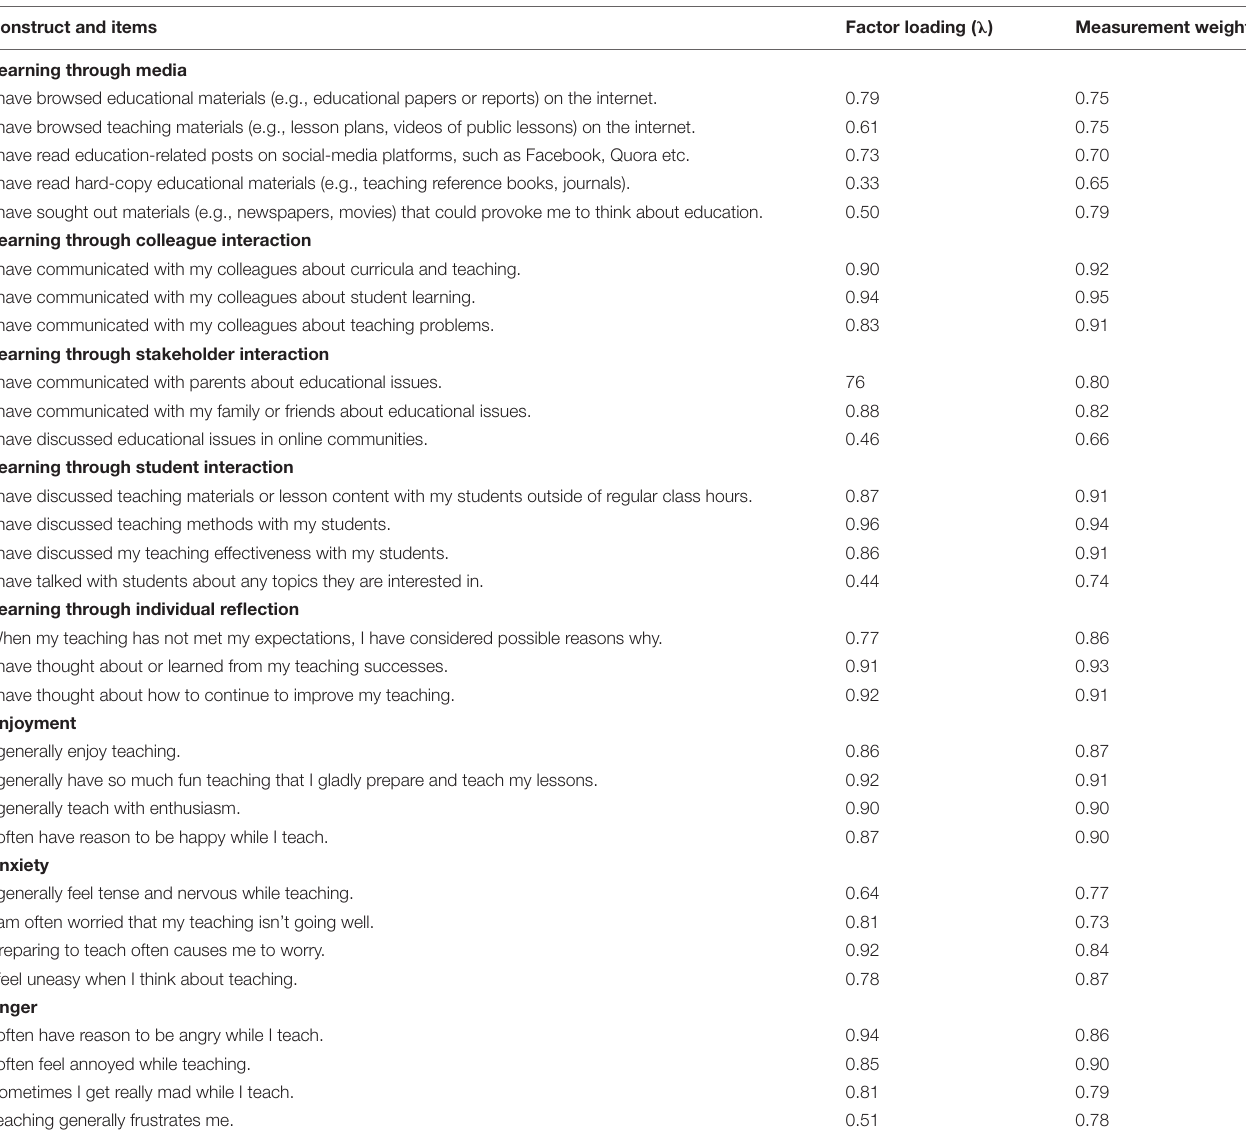
TABLE A1 | Standardised factor loadings for the items in each